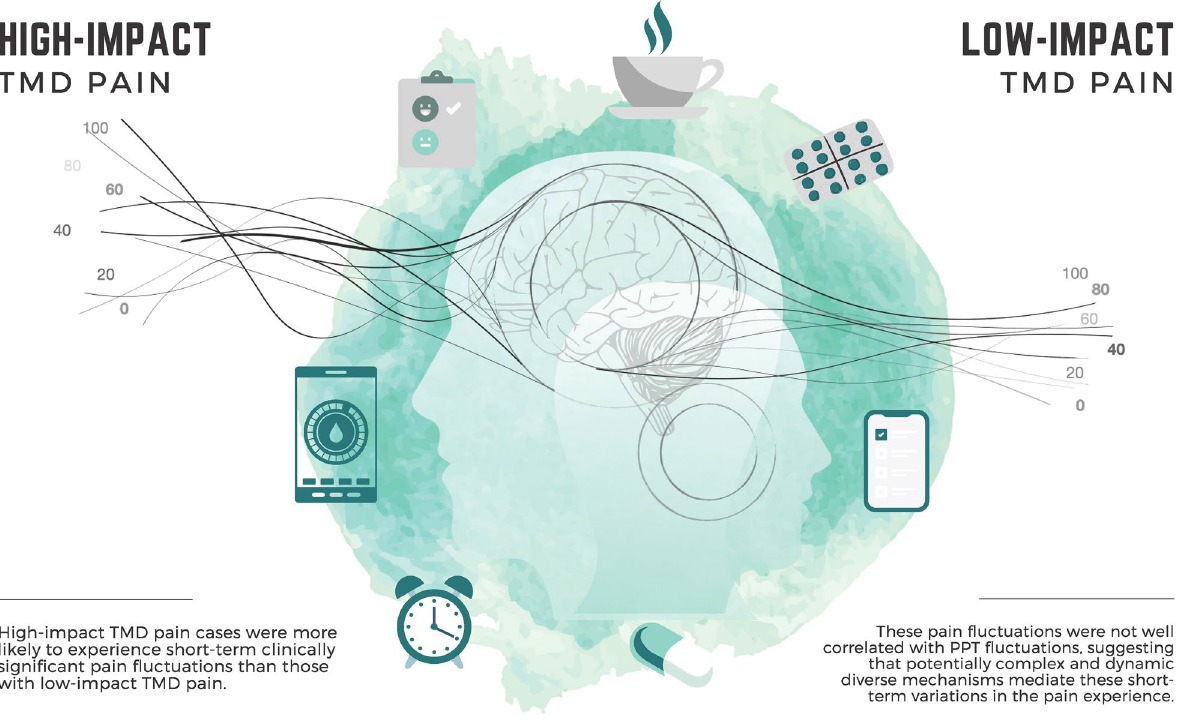
Figure 5. Graphical summary of the study from a conceptual illustration